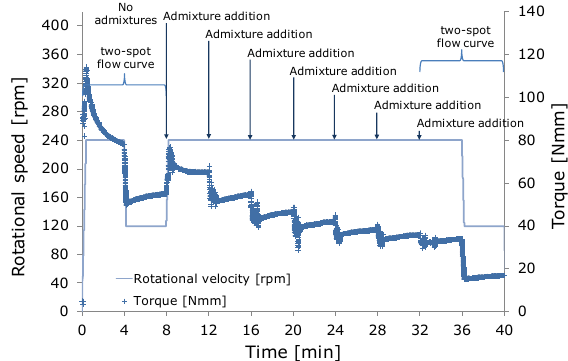
Figure 1. Experimental setup for the investigations of admixtures dosage effects at constant rotational